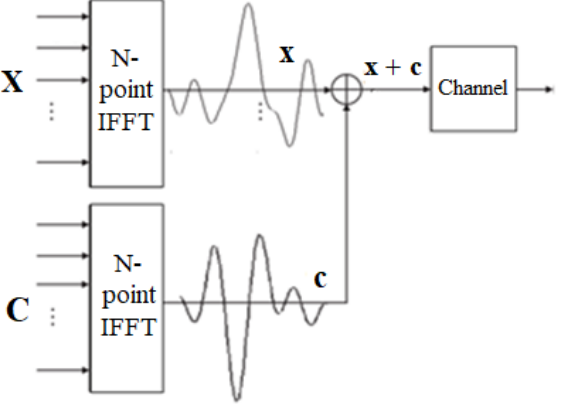
Figure 4. The block diagram of the TI scheme in OFDM systems.